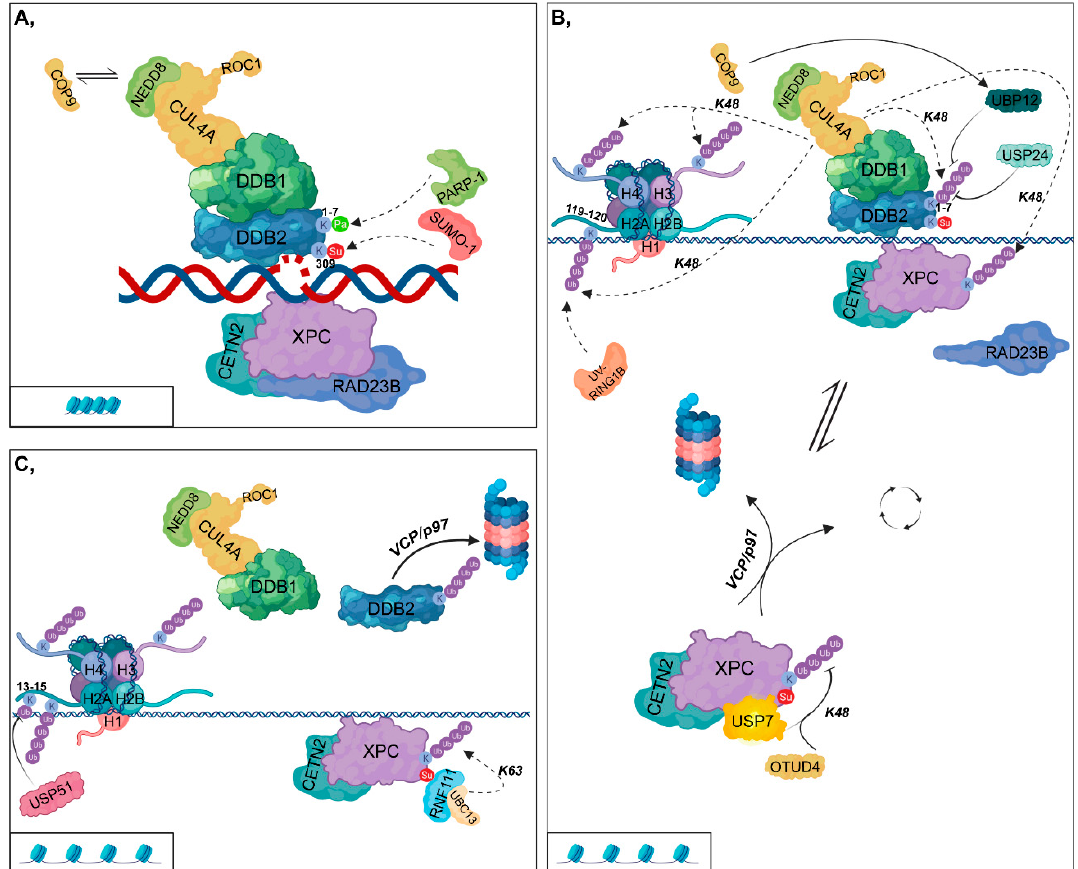
Figure 1. Global genomic-nucleotide excision repair ( A ) XPC (Xeroderma pigmentosum, complementationgroupC),complexedwithCETN2(Centrin2)andRAD23B(RAD23HomologB),binds to the opposite strand of helix-distorted lesions. In contrast, for CPDs (cyclobutane-pyrimidine dimers), XPC only binds to the damaged regions after the recruitment of the DDB1-DDB2 (DNA-Damage-Binding Protein 1 - DNA-Damage-Binding Protein 2) complex, which then forms a larger complex (CRL4 DDB2 ) with CUL4A (Cullin 4A) and ROC1 (RING-box protein 1 / RING subunit of SCF). SUMO-1 (Small ubiquitin-related modifier 1) and PARP-1 (Poly(ADP-ribose) polymerase 1) catalyze the SUMOylation and PARylation of DDB2 at K309 and at K1-7, respectively. CRL4 DDB2 activation requires the binding of NEDD8 (Neural Precursor Cell Expressed, Developmentally Down-Regulated 8). However, under physiological conditions, COP9 (Constitutive photomorphogenesis 9) replaces NEDD8, leading to the inactivation of the complex. ( B ) Following DNA-binding, RAD23B dissociates from XPC and at the same time, XPC is polyubiquitylated. CUL4A can di ff erentially a ff ect DDB2 and XPC, although it catalyzes the K48-linked polyubiquitylation of both proteins. UBP12 (Ubiquitin specific protease 12) (recruited by COP9) and USP24 (Ubiquitin specific peptidase 24) remove the ubiquityl groups from DDB2. The CRL4 DDB2 complex catalyzes the K48-linked polyubiquitylation of H3, H4, and H2A at K119 / 120, while UV-RING1B (UV-Ring Finger Protein 1) polyubiquitylates H2A at K119. OTUD4 (OTU deubiquitinase 4) and USP7 (Ubiquitin specific peptidase 7) participate in the removal of K48-linked ubiquityl groups from XPC. According to the ubiquitylation state of XPC, it can be either recycled or degraded in the proteasome. ( C ) USP51 (Ubiquitin specific peptidase 51) removes the ubiquityl groups from H2A K13 / 15. RNF111 (Ring Finger Protein 111, also known as Arkadia)-UBC13 (Ubiquitin-conjugating enzyme E2 13) catalyzes the K63-linked non-proteolytic polyubiquitylation of XPC. The K48-linked polyubiquitylation of DDB2 results in its dissociation from the CRL4 DDB2 complex and its subsequent VCP / p97 (Valosin-containing protein)-mediated proteasomal degradation. Chromatin structural changes (from compacted ( A ) to a more relaxed form ( B , C )) are represented in